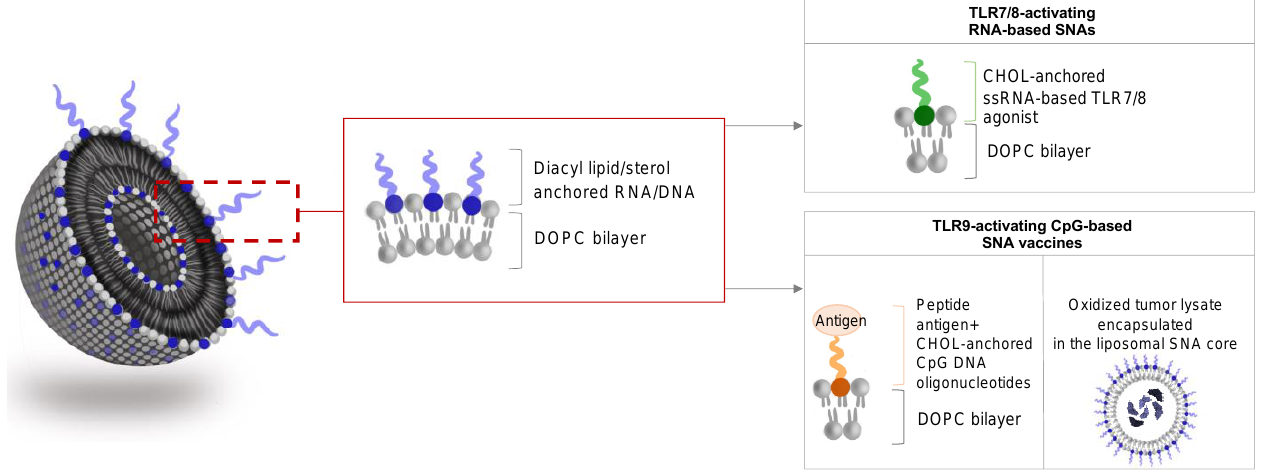
Figure 3. Liposomal SNAs for immune activation. SNAs are designed to carry TLR-activating oligonucleotides and antigenic peptides or are loaded with tumor cell lysates. DOPC, 1,2-dioleoyl-sn- glycero-3-phosphocholine; CHOL, cholesterol.